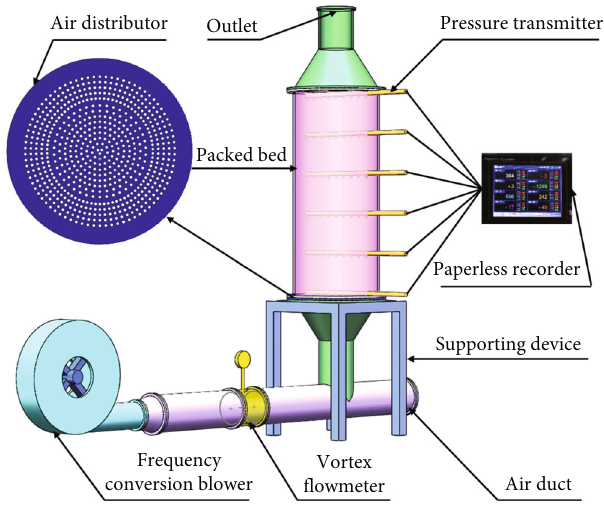
Figure 1: A sketch of the experimental apparatus for measuring the gas fl ow resistance in the sinter bed.